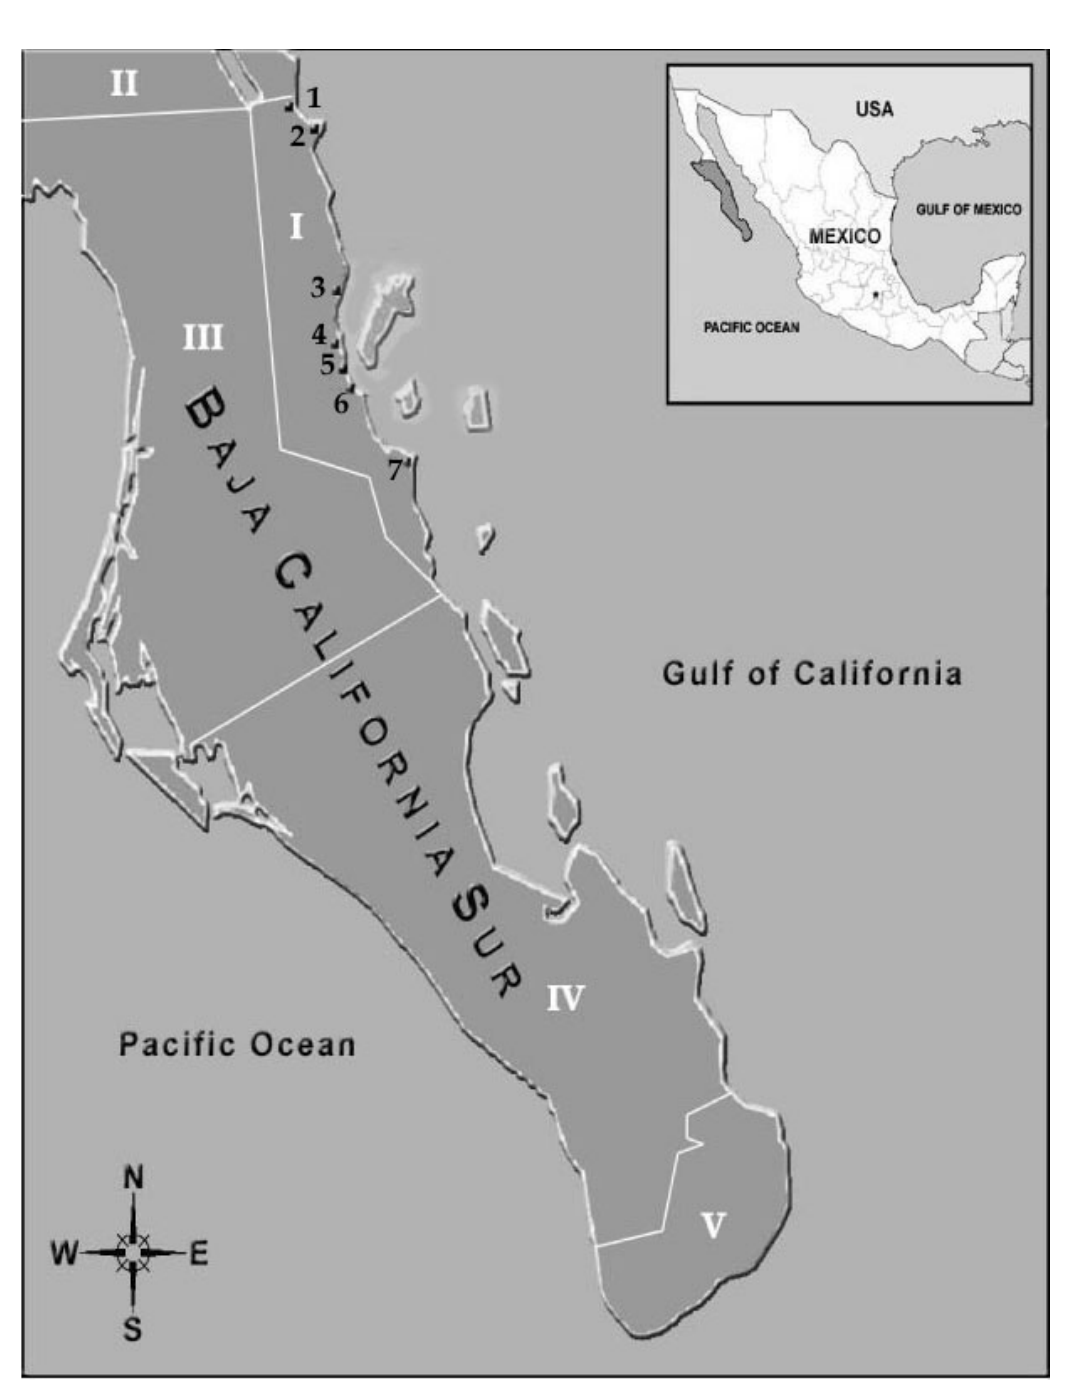
Fig. 1. Location of fishing communities studied: (1) Ramadita; (2) San Nicolás; (3) Loreto; (4) Colonia Zaragoza; (5) Juncalito; (6) Ligüí; (7) Ensenada Blanca; and (8) Agua Verde. Municipalities in the state of Baja California Sur: (I) Loreto; (II) Mulegé; (III) Comondú; (IV) La Paz; and (V) Los